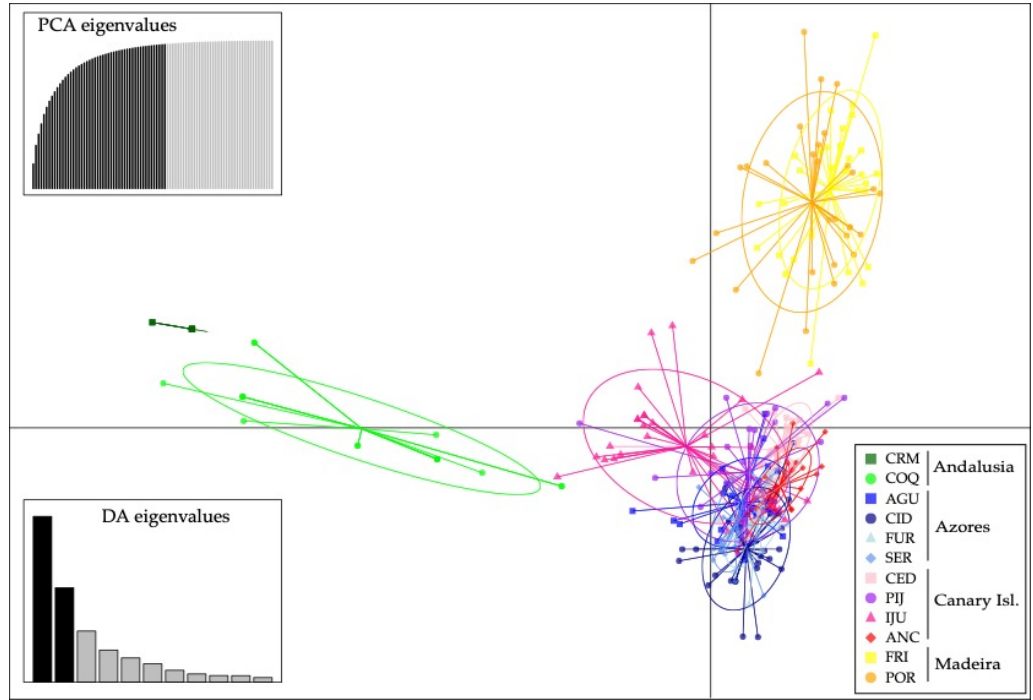
Figure 3. Result of the discriminant analysis of principal components (DAPC) using microsatellites.